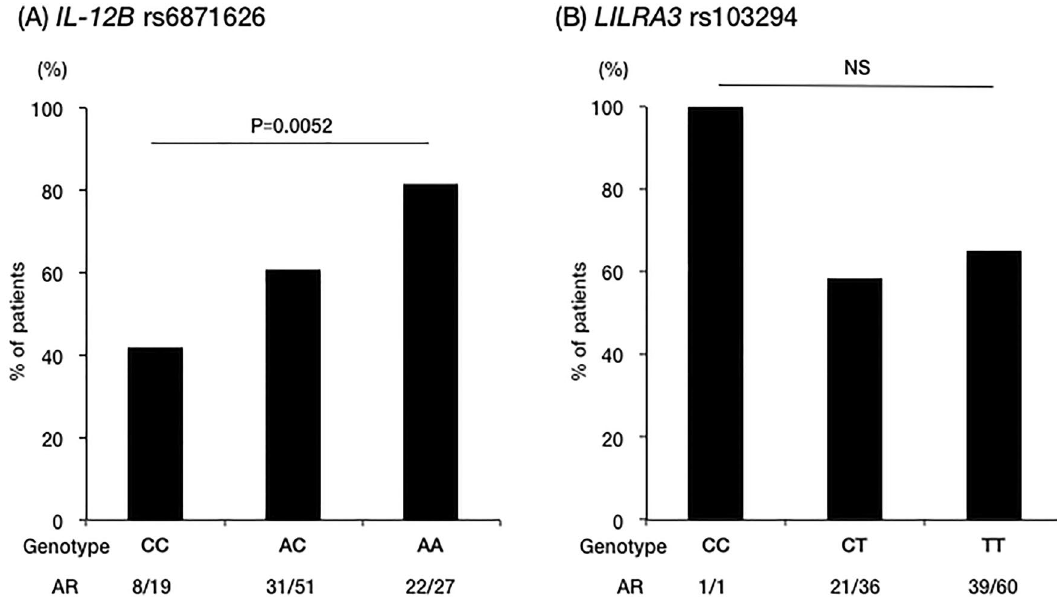
Figure 1. Association of genotypes with the frequency of AR. The association of ( A ) IL12B rs6871626 and ( B ) LILRA3 rs103294 with the frequency of AR. AR aortic regurgitation, NS not significant.